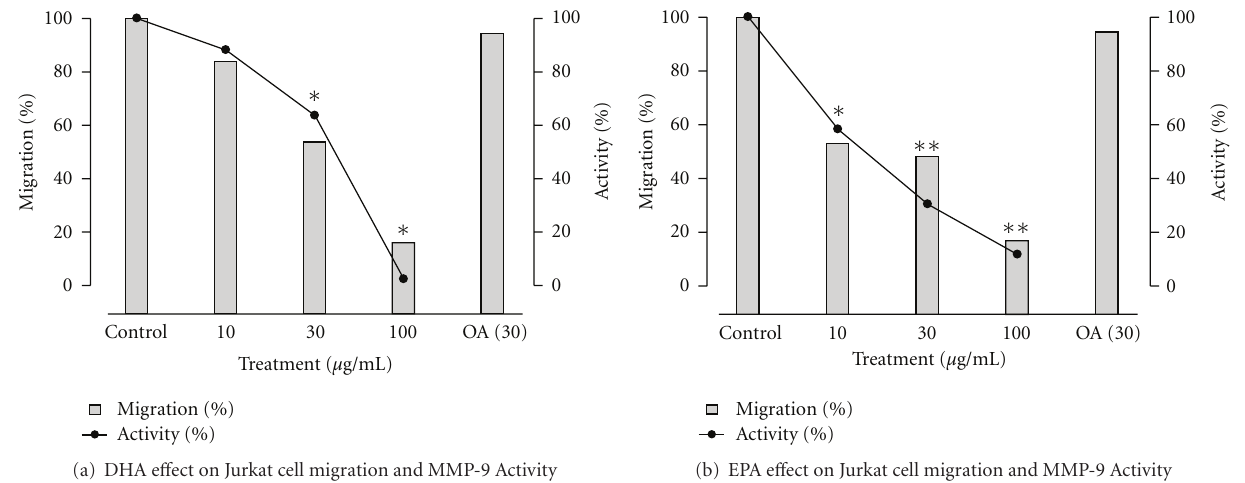
Figure 3: Jurkat cell migration is decreased following treatment with DHA or EPA when compared to an untreated control (100% migration). MMP-9 activity from Jurkat cell supernatants is decreased following treatment with DHA or EPA when compared to an untreated control (100% activity). Supernatants were collected from the cultures undergoing migration to determine MMP-9 activity by gelatin substrate zymography. Jurkat cells were incubated for 20 hr in the presence of 10, 30, and 100 μ g/mL of DHA or EPA. OA (30 μ g/mL) served as an oil control for cell migration. Migration assays were performed three separate times, representative data is displayed . ∗ Significant decrease in migration compared to control ( P ≤ 0 . 05). ∗∗ Significant decrease in Jurkat cell migration and MMP-9 activity compared to control ( P ≤ 0 .